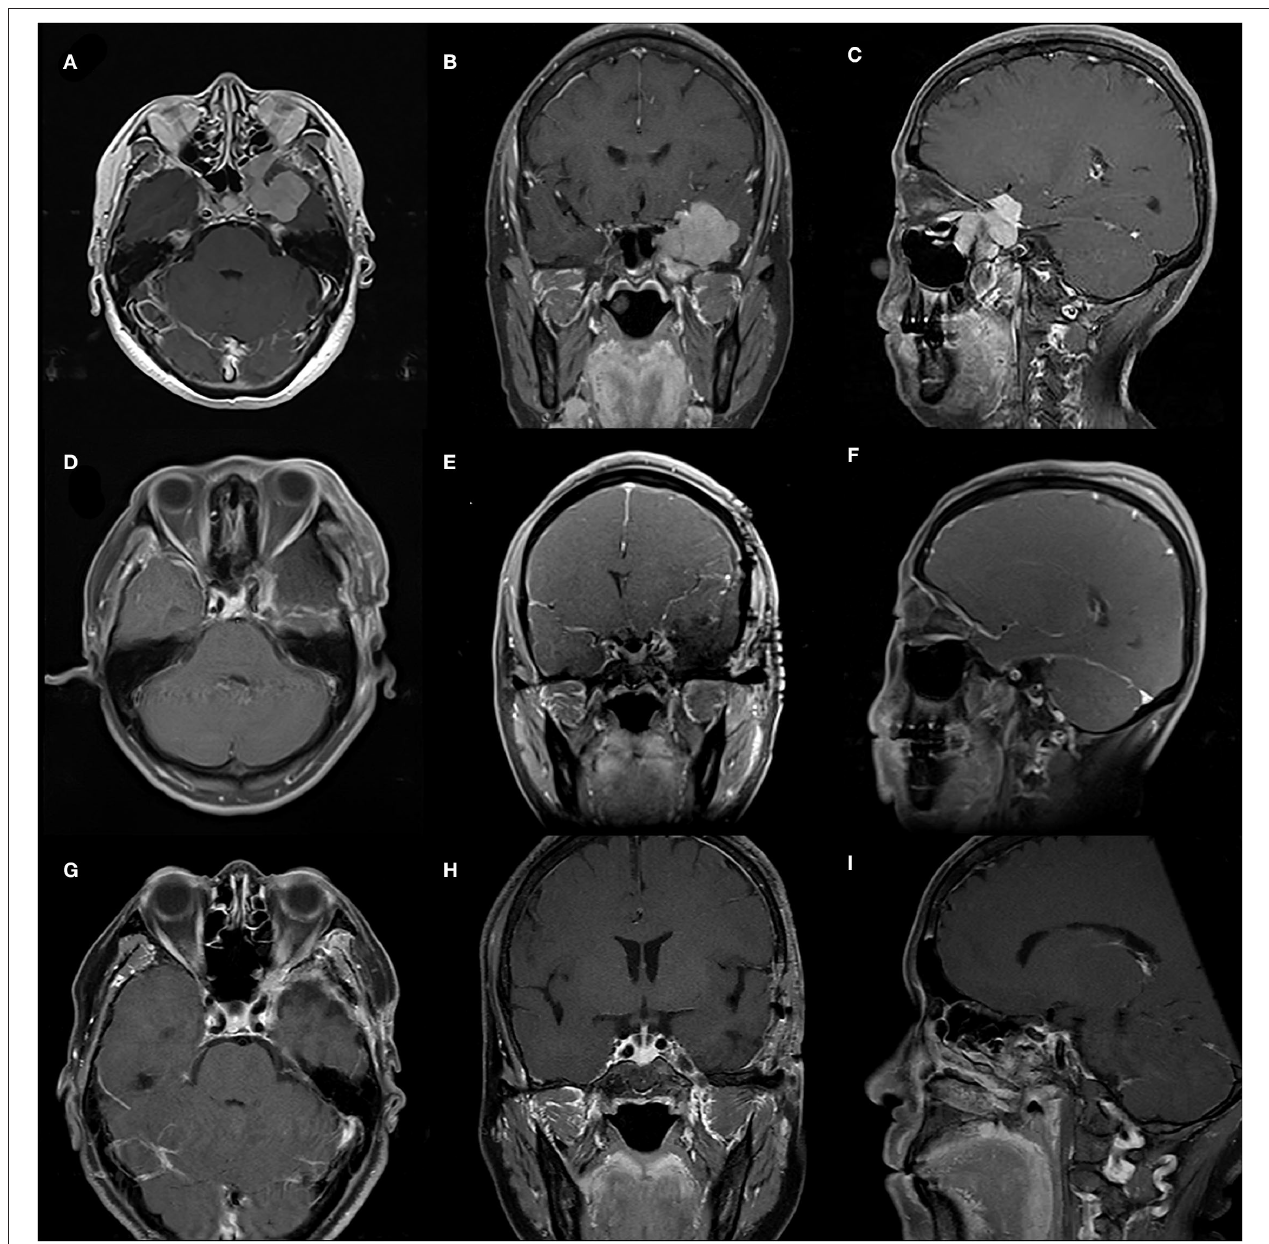
FIGURE 1 | A case of 55-year-old female with a WHO-grade-I meningioma. (A–C) Preoperative sellar region MRI showed an irregular lesion of left infraorbital fissure, orbital apex, pterygopalatine fossa, cavernous sinus and middle fossa. (D–F) Early postoperative MRI showing gross total resection of the meningioma. (G–I) MRI follow-up 6 months postoperatively showing no tumor